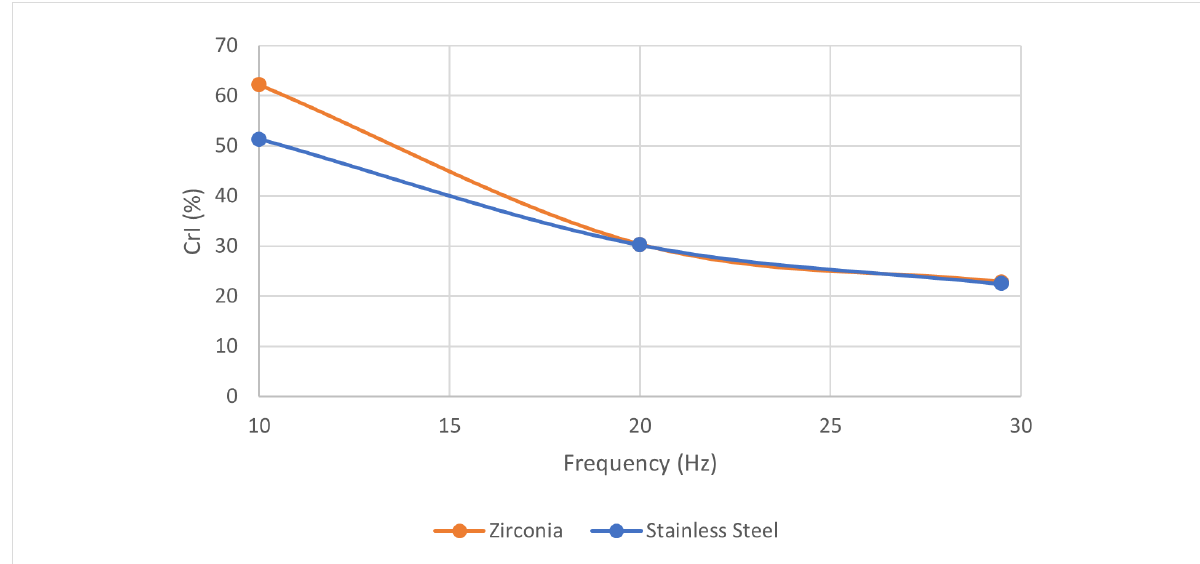
Figure 3: Crystallinity index (%) after milling as a function of frequency. ZrO 2 and SS jars are compared, both with 1 2 g ball of the same material. Ex- perimental conditions: 200 mg of chitin, milling time: 30 min, milling frequencies varied from 10, to 20 and 29.5 Hz.